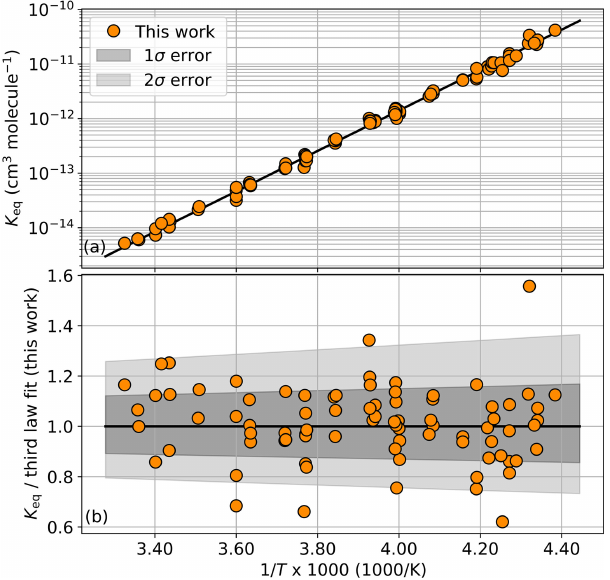
Figure 3. (a) Experimental K eq values as a function of 1000 /T . The black trace is a third-law fit of the orange circles, K eq = 2 . 16 × 10 − 27 e ( 8527K /T) cm 3 molecule − 1 . Individual values are enumer- ated in Table 1. (b) Ratio of experimental K eq values to the third- law fit. Dark gray shading encompasses the total estimated 1 σ error from this study and light shading encompasses the 2 σ